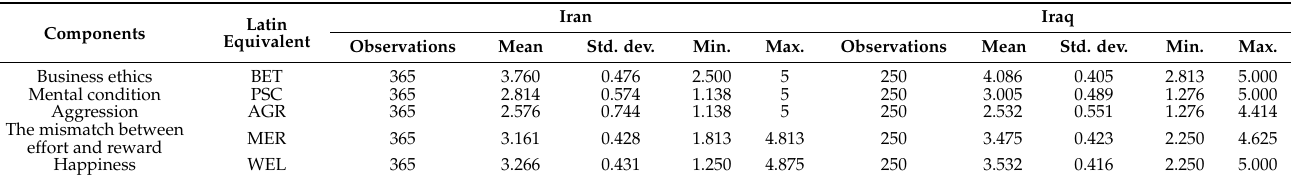
Table 8. The Descriptive statistics of hidden research variables.